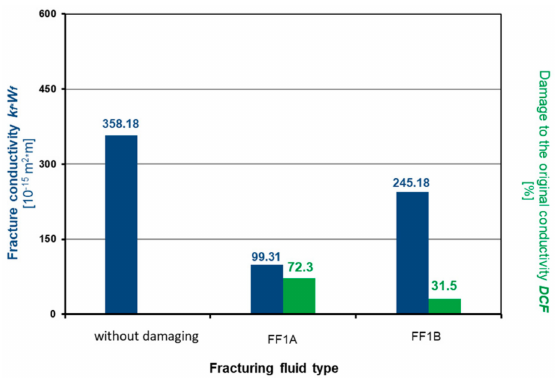
Figure 6. The damage to the primary conductivity of the fracture filled with quartz sand proppant 20/40 done by fracturing fluids FF1A and FF1B at a temperature of 60 ◦ C; compressing stress 27.6 MPa.